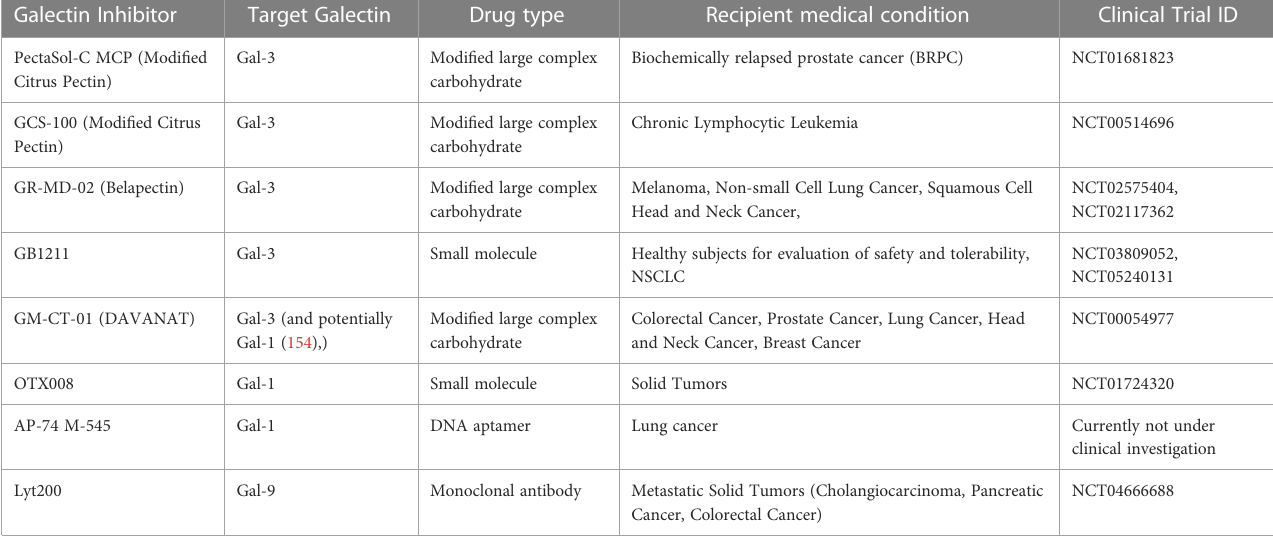
TABLE 2 Summary of the types and characteristics of candidate galectin inhibitors that have entered or may enter clinical evaluation in the context of cancer therapy. Galectin